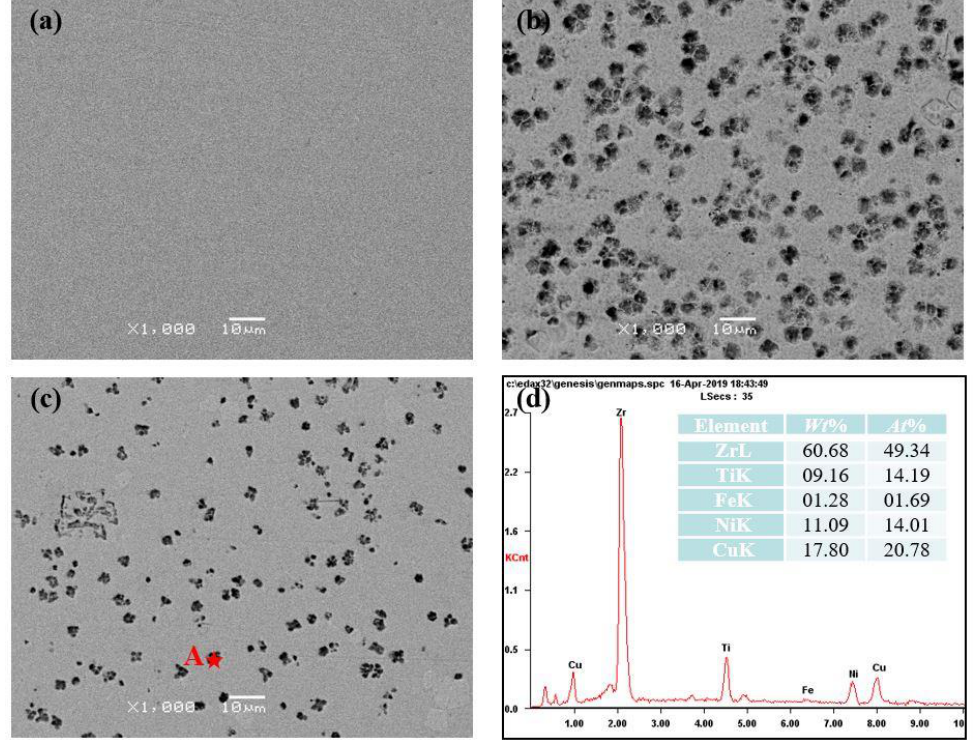
Figure 4. The different morphologies of ( a ) the remelting zone (RZ), ( b ) the heat-affected zone (HAZ) near the RZ and ( c ) away from the RZ. ( d ) shows the EDS results of point “A”.